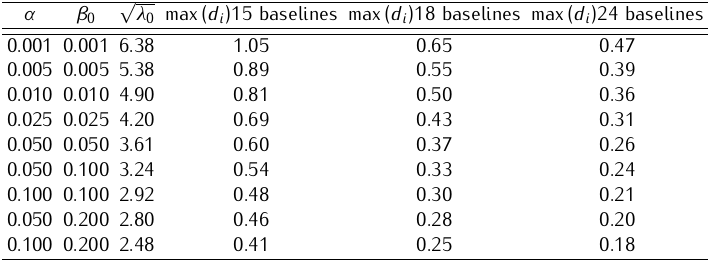
Table 3. Significance levels, non-centrality parameters and maximum displacement values (mm).